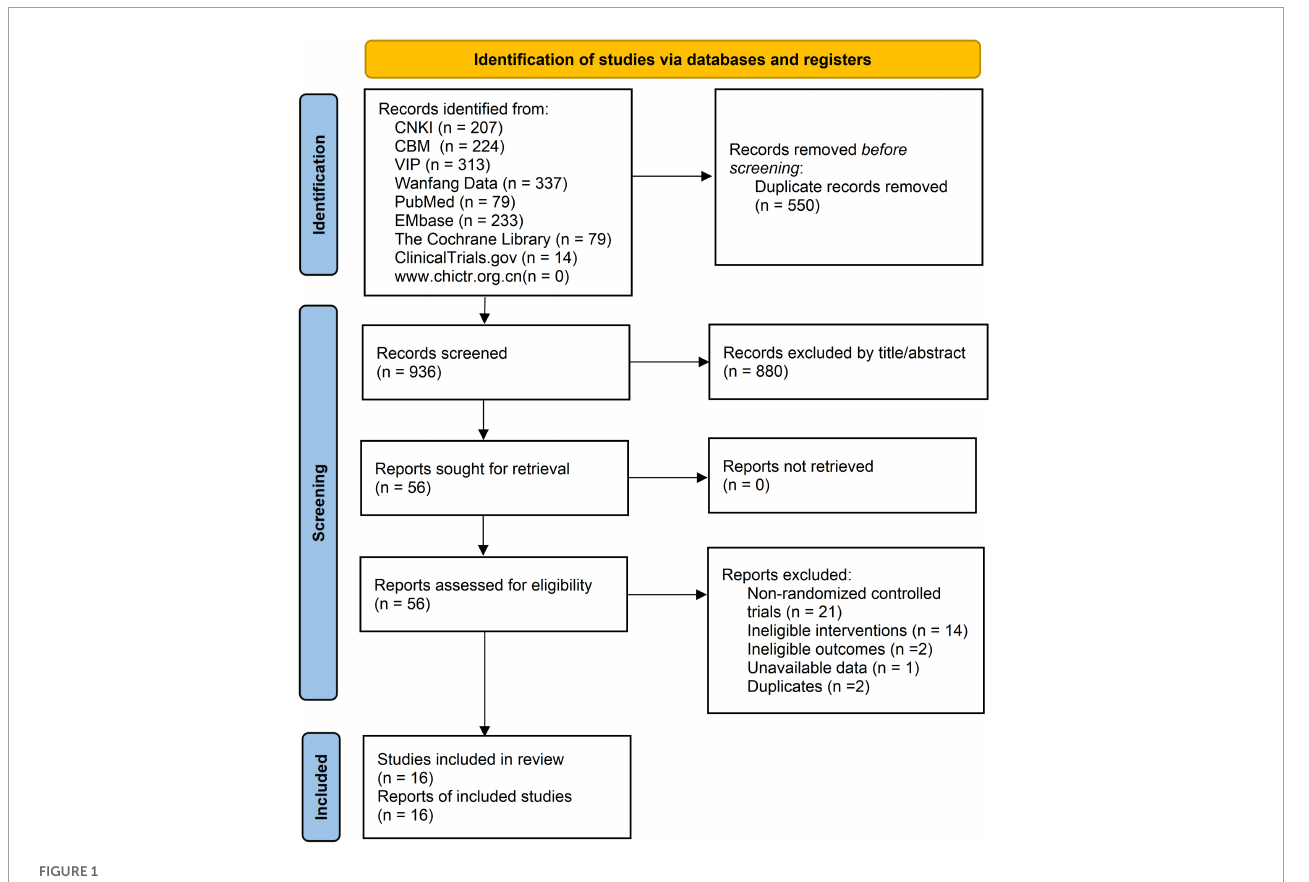
FIGURE1 PRISMA flow